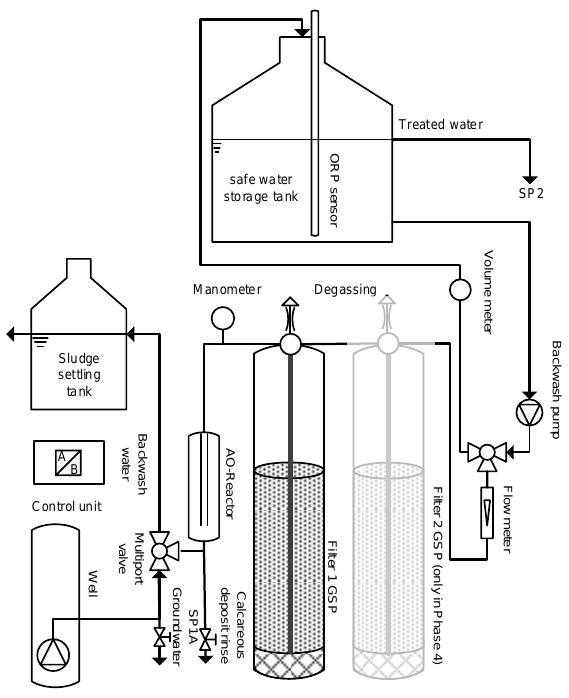
Figure 6. Pilot setting in West Bengal.